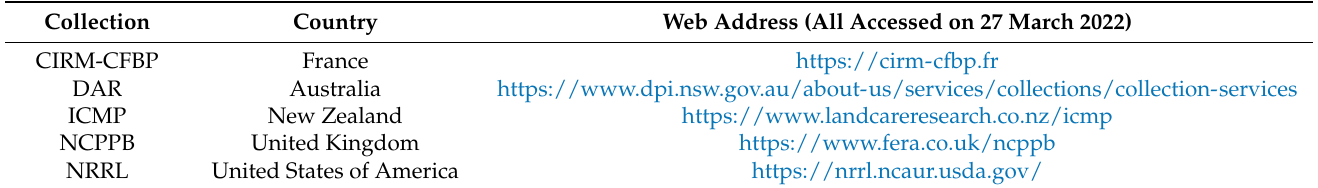
Table 2. International culture collection that specialize in accessioning and distributing plant- associated bacteria from countries around the